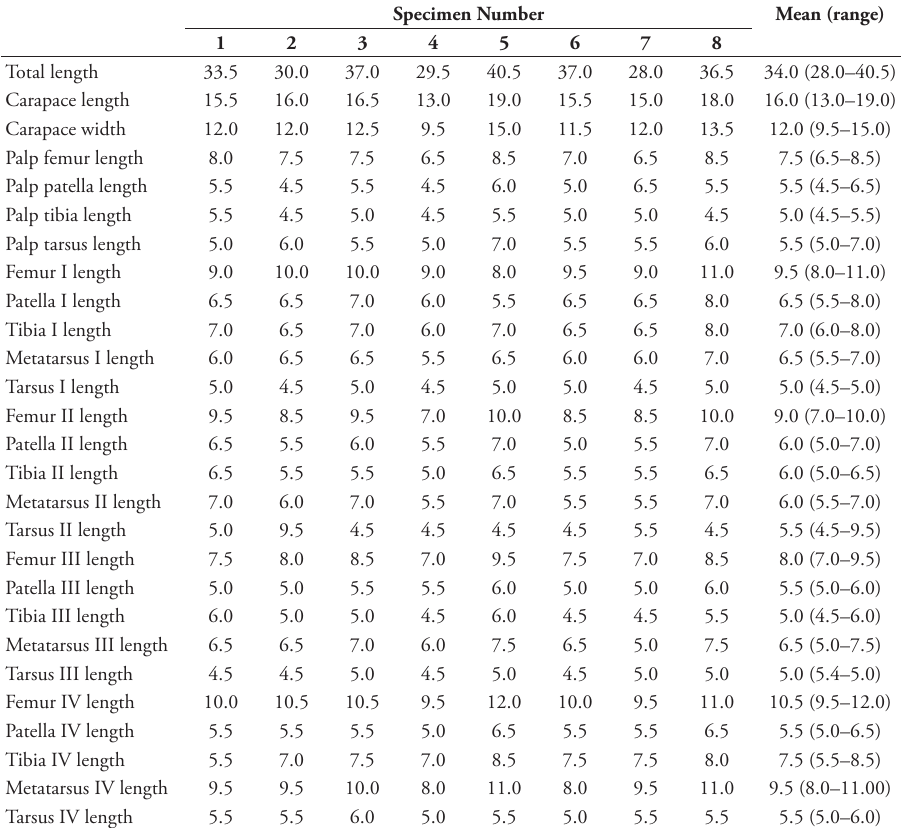
Table 2. Measurements of female specimens of the type series and two additional